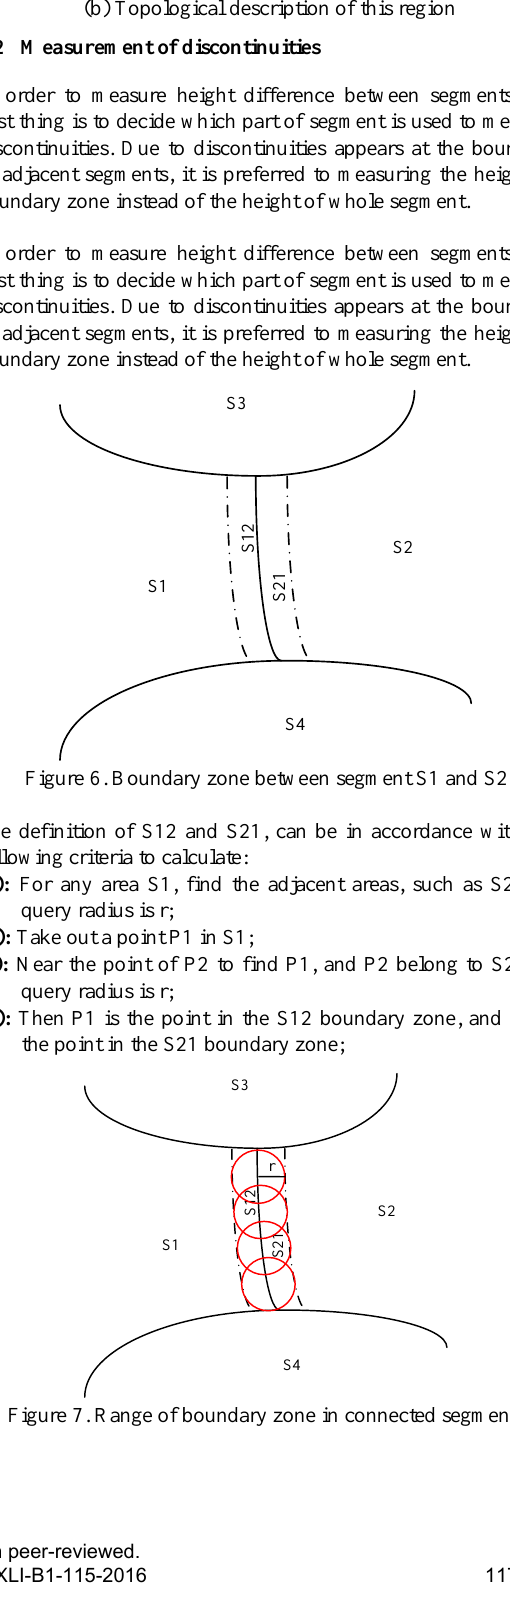
Figure 5. (a) Spatial arrangement of segments (b) Topological description of this region